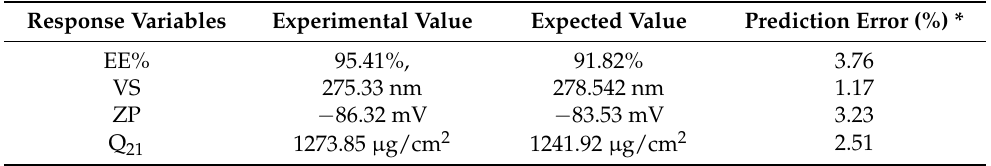
Table 4. Experimental, modelexpectedandpredictionerrorvaluesoftheoptimizedDNa-BSVCformulation. Response